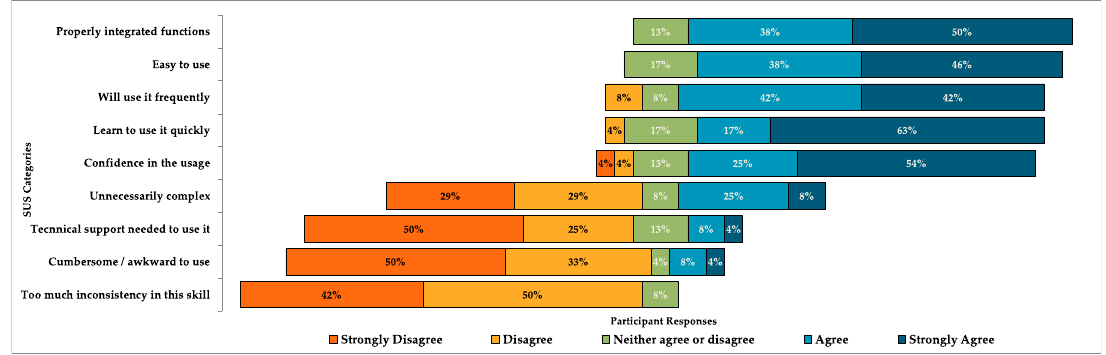
Figure 4. Skill prototype SUS Evaluation Results.